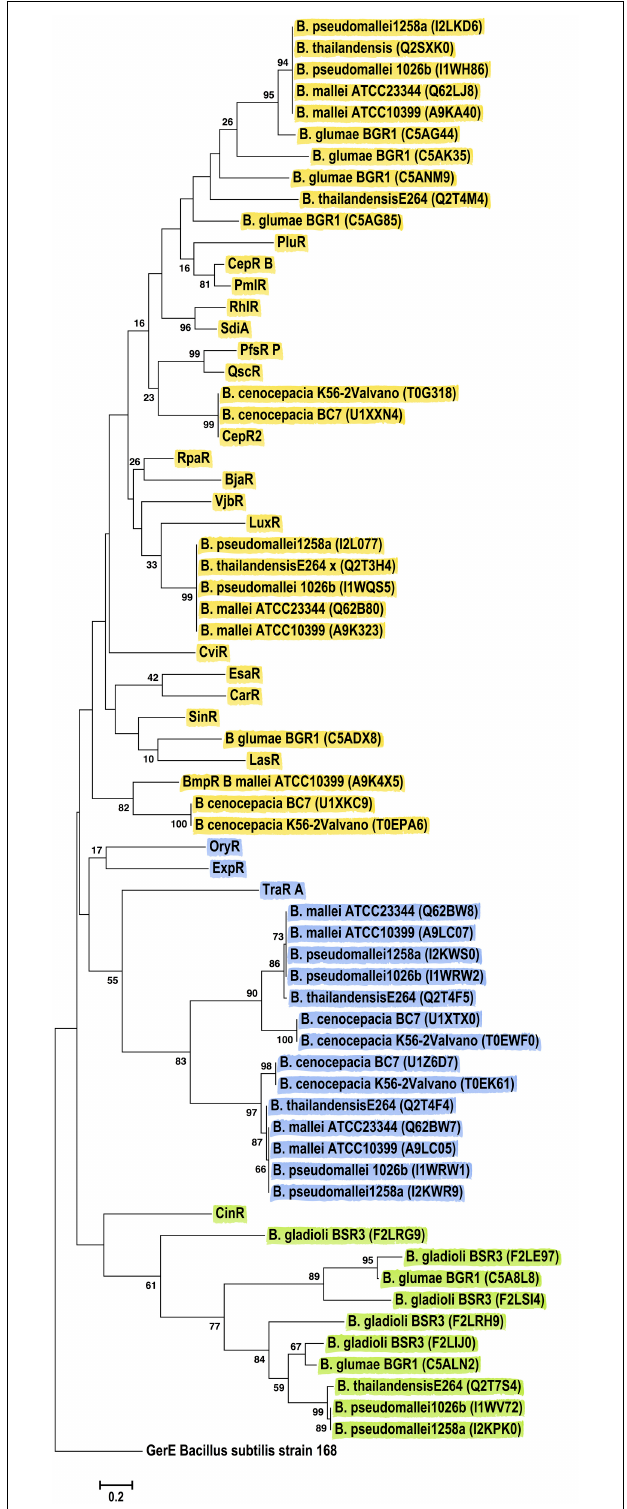
FIGURE 6 | Phylogenetic analyses of multiple LuxR solos carried by the Betaproteobacteria. The tree was inferred by using the Maximum Likelihood method. Tree is drawn to scale, with branch lengths measured in